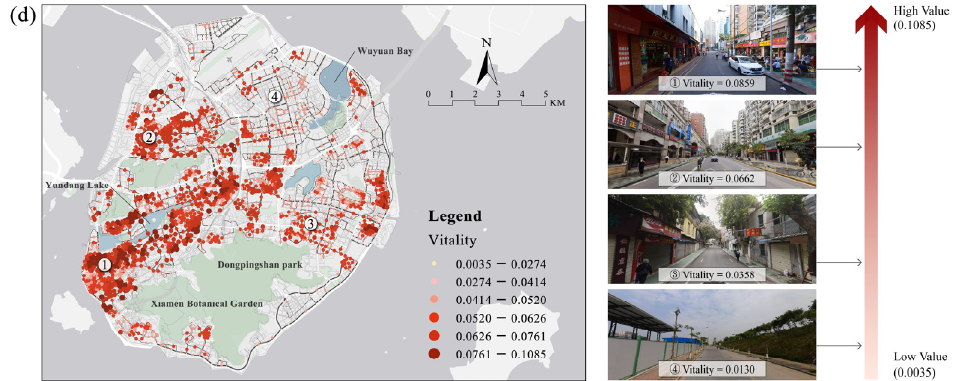
Figure 9. Spatial distribution of assessment results for each dimension of street safety: ( a ) walkability, ( b ) spatial enclosure, ( c ) visual permeability, and ( d ) vitality. The maps are categorized by the natural discontinuity method so that the high-value areas and the low-value areas of each dimension can be better distinguished according to the data’s own attributes. The actual photos of the streets corresponding to the different assessment scores of each dimension are also shown, and the locations are marked on the map.